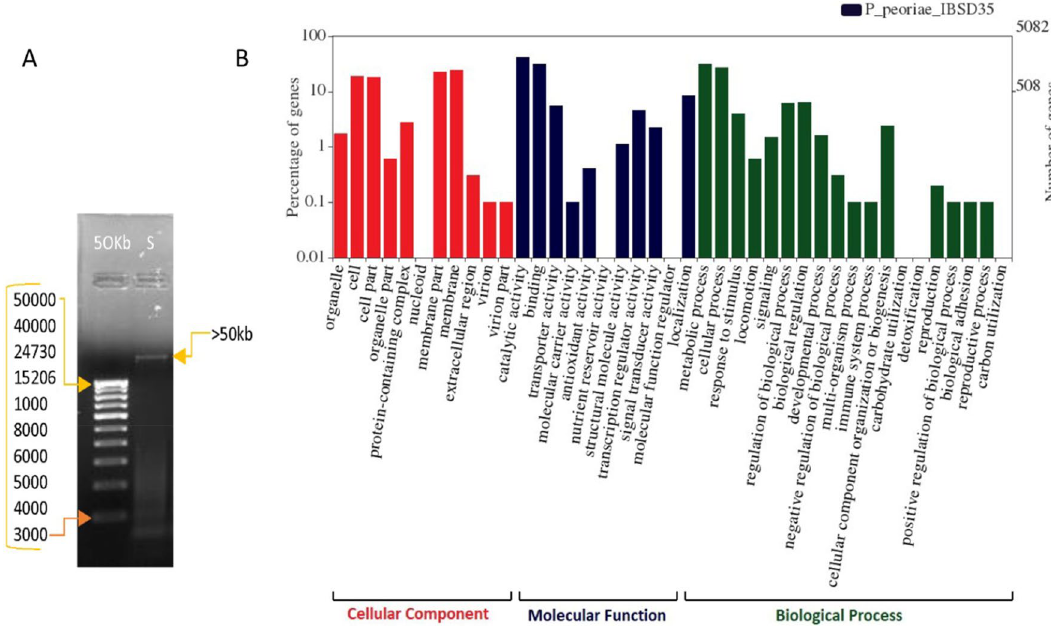
Figure 5. ( A ) The crude gDNA band quality checked on 0.8% agarose gel, where Marker lane is 50 kb DNA ladder and, lane S is DNA whose molecular weight is more than 50 kb. ( B ) The WEGO analysis of P. peoriae IBSD35 genome. The gene ontology of genome has been classified into cellular component (Red), molecular function (Blue), and biological process (green) categories. The numbers of the genes are indicated in extra-cellular trehalose, cellobiose, and maltose. It revealed the P. Peoriae IBSD35 auxotrophic lifestyle (www. kegg. jp/ kegg/ kegg1. html) 42,43 . The Joint Genome Institute-Integrated Microbial Genomes and Microbiomes Sys- tem (JGI-IMG/M) analysis revealed a putative horizontally transferred genes count of 10 (0.19%) with the best hits to genes from Proteobacteria and Clostridia . The trans-membrane count is 1392 (26.28%) and might serve as a gateway to transport specific substances across the membrane 28,29 . The signal peptide is 303 (5.72%) of the total CDS identified. It might prompt the translocation of a cell protein secretion 44,45 . sensor histidine kinase and response regulators, two Des K– Des R of the NarL family, four Che A– Che Y of a chemo-taxis family, two Res - Res D, and two Deg S- Deg U for motility, regulation, and interactions. Flagellar pro- teins (fliS) in the cellular chaperones might cause microbe motility and signal transduction. A flagellin/flagellar hook-associated protein ( fli C) includes glycerol kinase and molecular chaperone (HtpG) that might involve in plant–microbe interaction 48 . P. peoriae IBSD35 genome also harbored biodegradation capability proteins for xenobiotic compounds 49 . Comparison of genomes characteristics. The selected Paenibacillus species have shown varying num- bers of DNA scaffolds ranging from 1 to 56. Paenibacillus sp. JDR-2 has the largest genome size (7,184,930 bp), and B. subtilis subtilis AG1839 has the smallest genome size (4,193,640 bp) among the selected genomes (Table 3). The dot plot homology revealed a low level of P. peoriae IBSD35 synteny with Paenibacillus peoriae KCTC 3763 but a higher synteny with Paenibacillus peoriae HS311, P. polymyxa SC2, and P. polymyxa E681 (Sup- plementary Fig. S4). The predicted numbers of nonribosomal peptide synthase (NRPS) BGCs ranged from 0 to 18 among the eleven genomes indicating their diverse and rich SM natural products (Table 3). P. peoriae IBSD35 harbored 18 NRPS (72% of the total 25 BGCs) and encompassed the highest number of NRPS BGCs among the selected genomes comparisons. Antibiotics and other secondary metabolites (SMs) gene cluster of P. peoriae IBSD35. The CFS of P. peoriae IBSD35 has shown a high and broad-spectrum antimicrobial activity against S. aureus ATCC 25923, E. coli ATCC 25922, C. albicans ATCC 10231, Klebsiella pneumoniae ATCC 4352, and Salmonella typhimurium ATCC 14028 (Fig. 1A–E). The activity was comparable with ampicillin and nisin at a much lower dose. Anti- biotics and Secondary Metabolite Analysis Shell (AntiSMASH) v5 using Integrated Microbial Genomes Atlas of Biosynthetic gene clusters (IMG-ABC) web server tools predicted P. peoriae IBSD35 harbored 25 BGCs 50,51 . LC–MS sequencing of RP-HPLC purified sample have predicted 15 protein lists (Table 3). Paenibacillus peoriae IBSD35 harbored resistance genes for beta-lactam, vancomycin, cationic antimicrobial peptide (CAMP), platinum drug, and antifolate drug 52–55 . The Rapid Annotation of microbial genomes using Sub- systems Technology (RAST) tool predicted that the P. peoriae IBSD35 genome harbored 29 compounds resistant